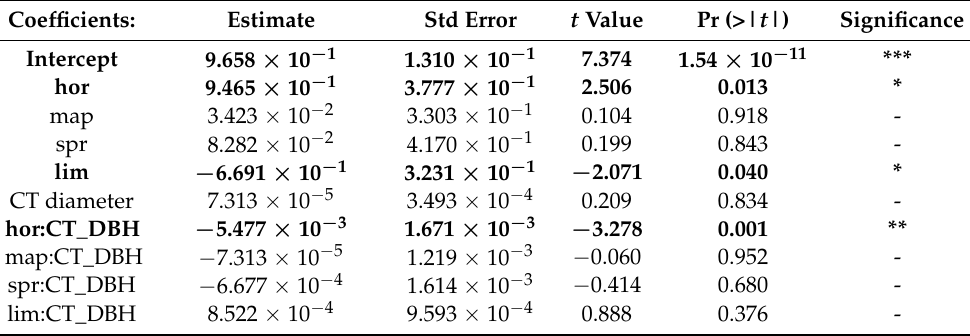
Table 1. Linear model ((mingling ~CTspecies*CT_DBH); Resid. SE: 0.1782, Multiple R -squared: 0.4573, Adj. R -squared: 0.4209, F -statistic: 12.55 on 9 and 134 df, p = 2.678 × 10 − 14 ) assessing the